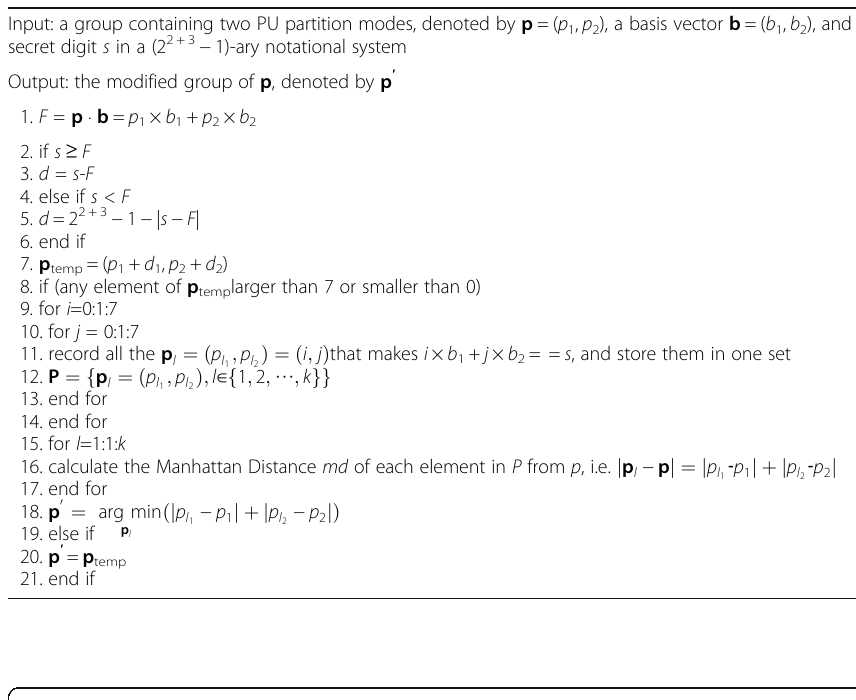
Table 11 The pseudocode of the embedding process of one PU partition modes group from 16 ×16-sized